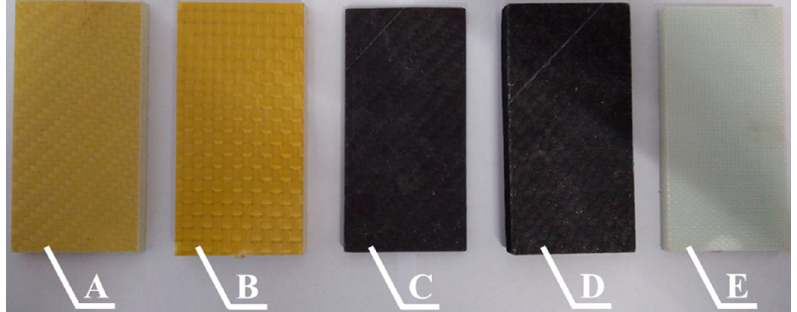
Figure 2. Samples cut from epoxy composites with sixteen layers of reinforcing fibers: A —Twaron 2200, B —Kevlar 49, C —Pyrofil TR30 S, D —HR 12K, E —Dyneema SK 60.